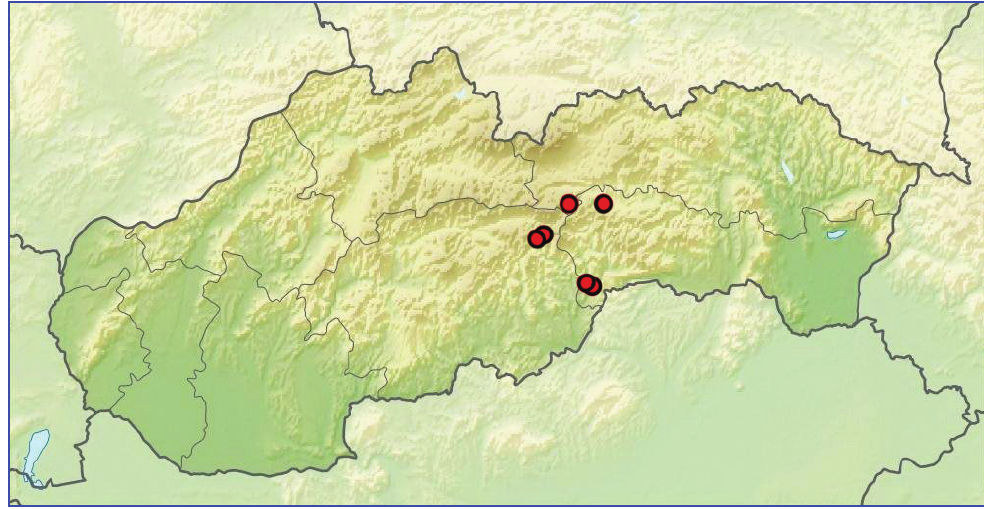
being the primary food substrate of species in the E. wilkella -group. Eulamprotes gemerensis oc- curs on xerothermic limestone slopes and the flight period is between late May and early August.